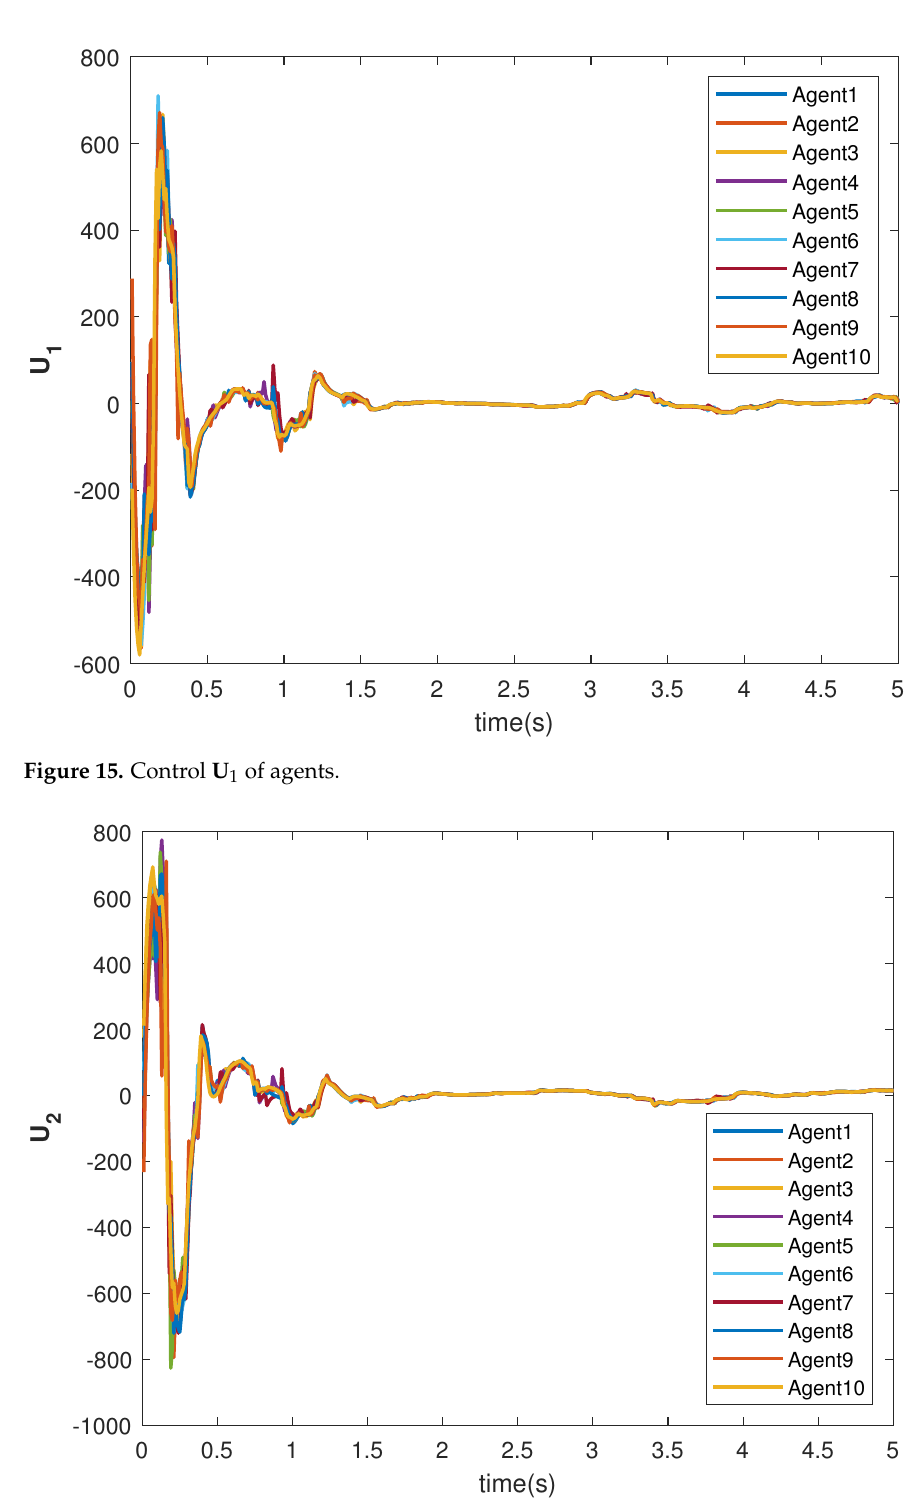
Figure 16. Control U 2 of